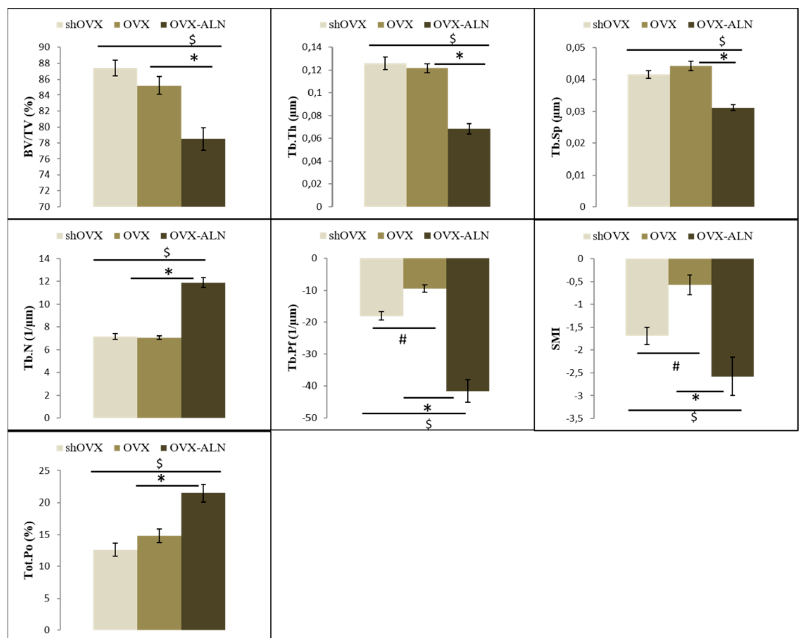
Figure 2. Bar diagrams illustrating the micro ‐ architectural parametric values of the trabecular bone of the mandibular condyle. BV/TV, bone volume/tissue volume; Tb.Th, trabecular